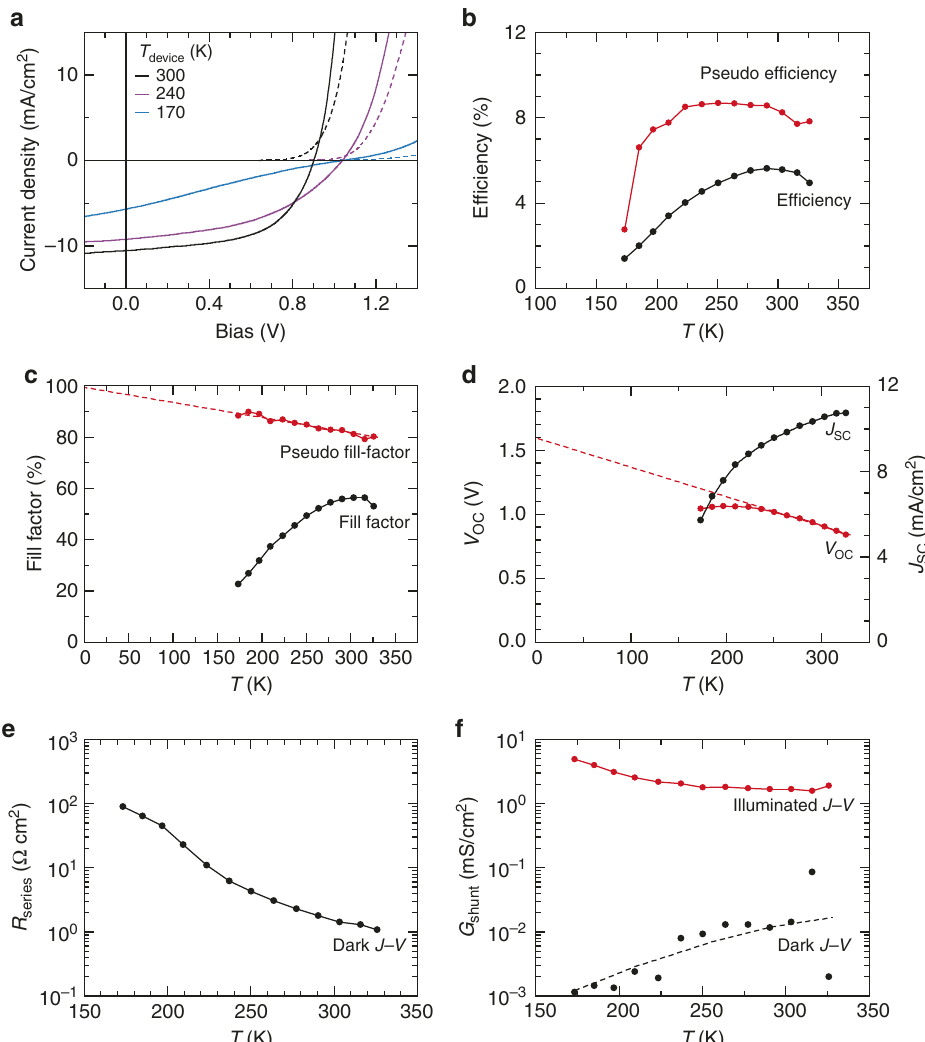
Fig. 5 Temperature-dependent J – V characteristics of the SnO 2 :F/ZnMgO/Se/MoO x /Au device. a Current – voltage ( J – V ) plots under 1-Sun illuminated ( solid line ) and dark ( dashed line ) conditions measured at the device temperature of 300 °K ( black ), 240 °K ( purple ), and 170 °K ( blue ). b Ef fi ciency ( black ) and pseudo-ef fi ciency ( red ) plots. c Fill factor ( black ) and pseudo- fi ll-factor ( red ). The pseudo-ef fi ciency and pseudo- fi ll-factor were extracted from the short circuit current ( J SC ) — open-circuit voltage ( V OC ) measurements under various illumination intensities. d J SC ( black ) and V OC ( red ). e Series resistance ( R S ) extracted from dark J – V measurements. f Shunt conductance ( G sh ) extracted from the illuminated ( red ) and dark ( black ) J – V